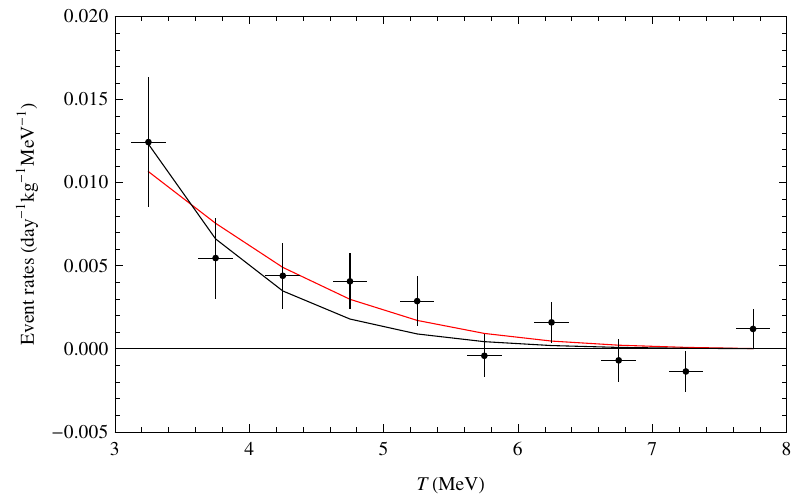
Figure 6 . Event rates of (cid:23) e + e (cid:0) elastic scattering in the TEXONO experiment. The black points represent the measured data, taken from [44]. The black and red curves are the SM prediction and the best (cid:12)t,